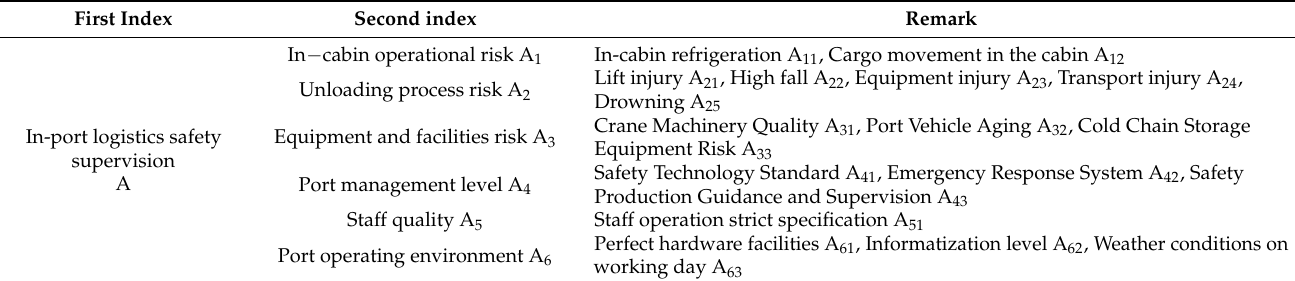
Table 1. ICCL safety supervision index